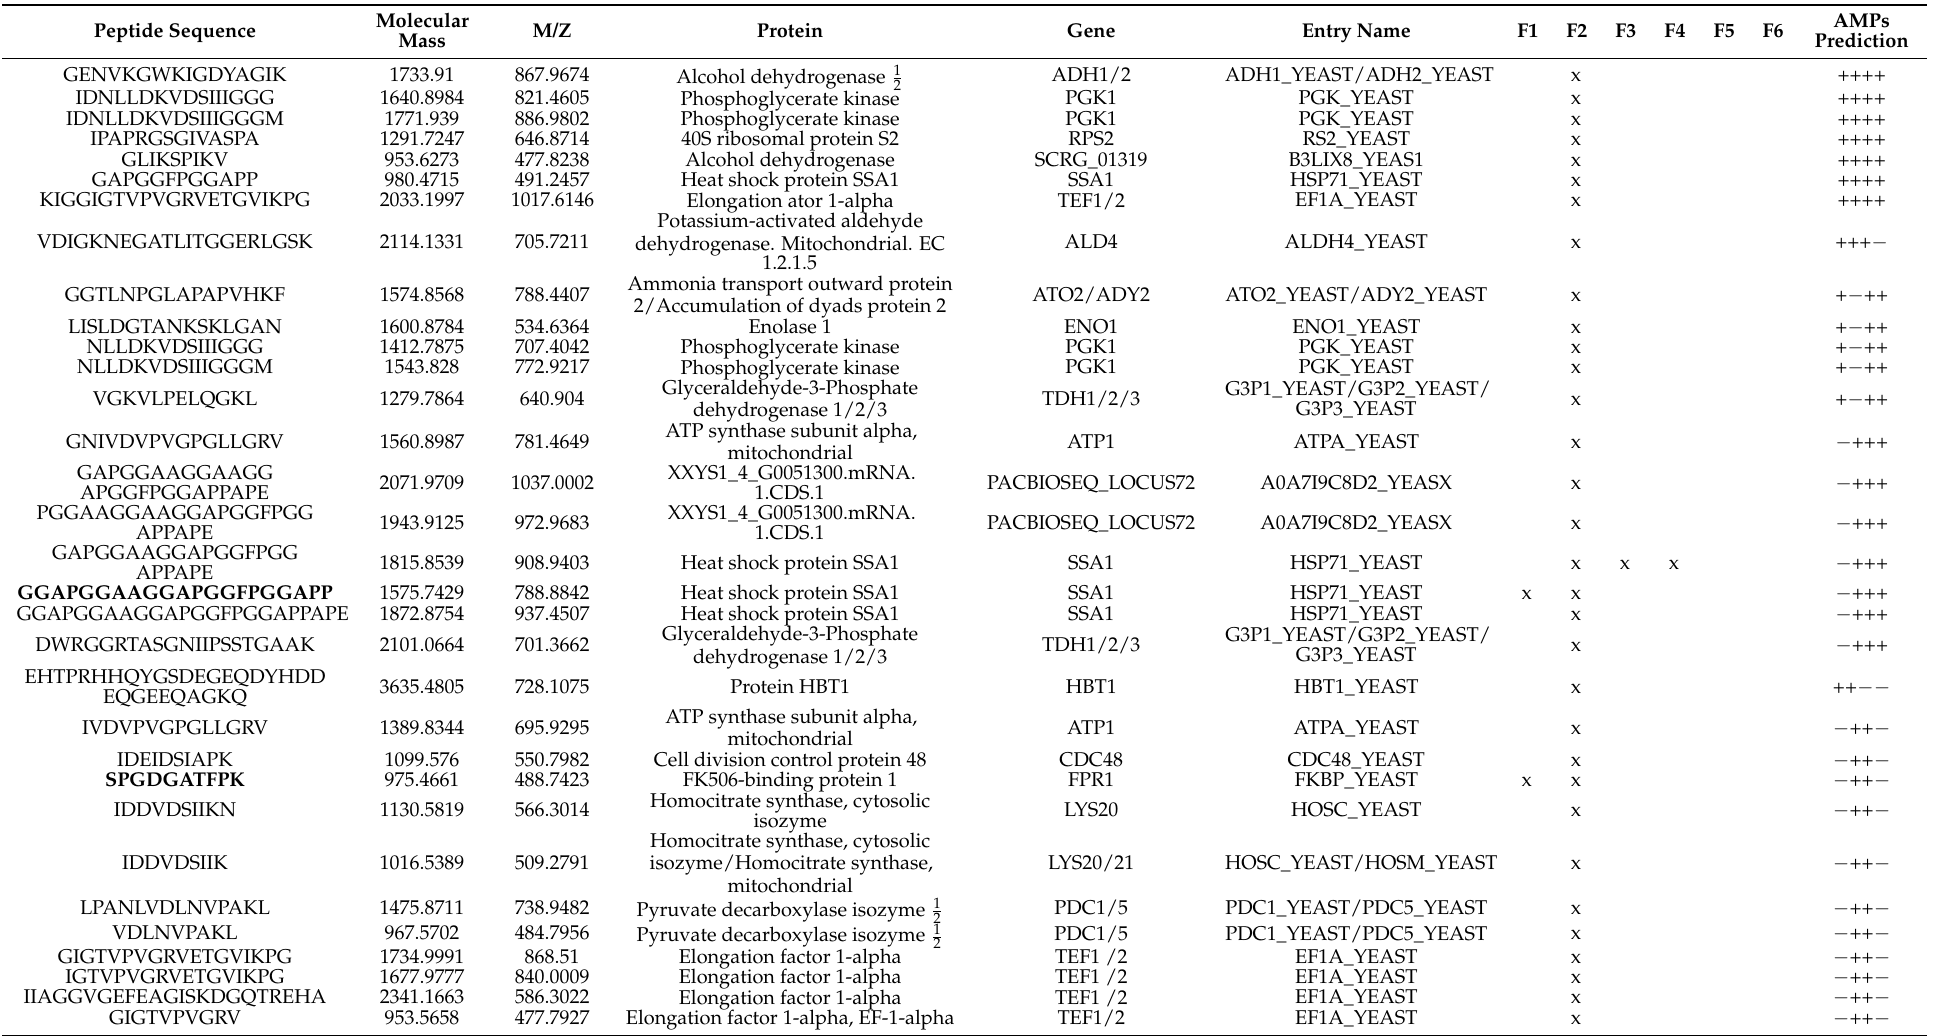
Table 3. Potential AMP candidates screened by an in silico investigation using four independent